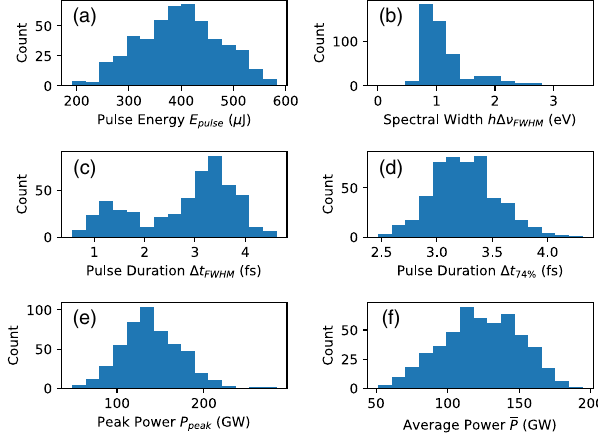
FIG. 12. Statistics of 500 shots of the simulation in Sec. III C. Histograms of (a) the pulse energies E , (b) the spectral widths pulse h Δ ν defined as the full width at half maximum (FWHM) in FWHM the frequency domain, (c) the pulse durations Δ t defined as FWHM the FWHM in the time domain, (d) the pulse durations Δ t 74% defined as the shortest duration containing 74% of the pulse energy, (e) the peak powers P , and (f) the average pulse power peak ¯ P ¼ E = Δ t of each XFEL shot defined as 74% . pulse